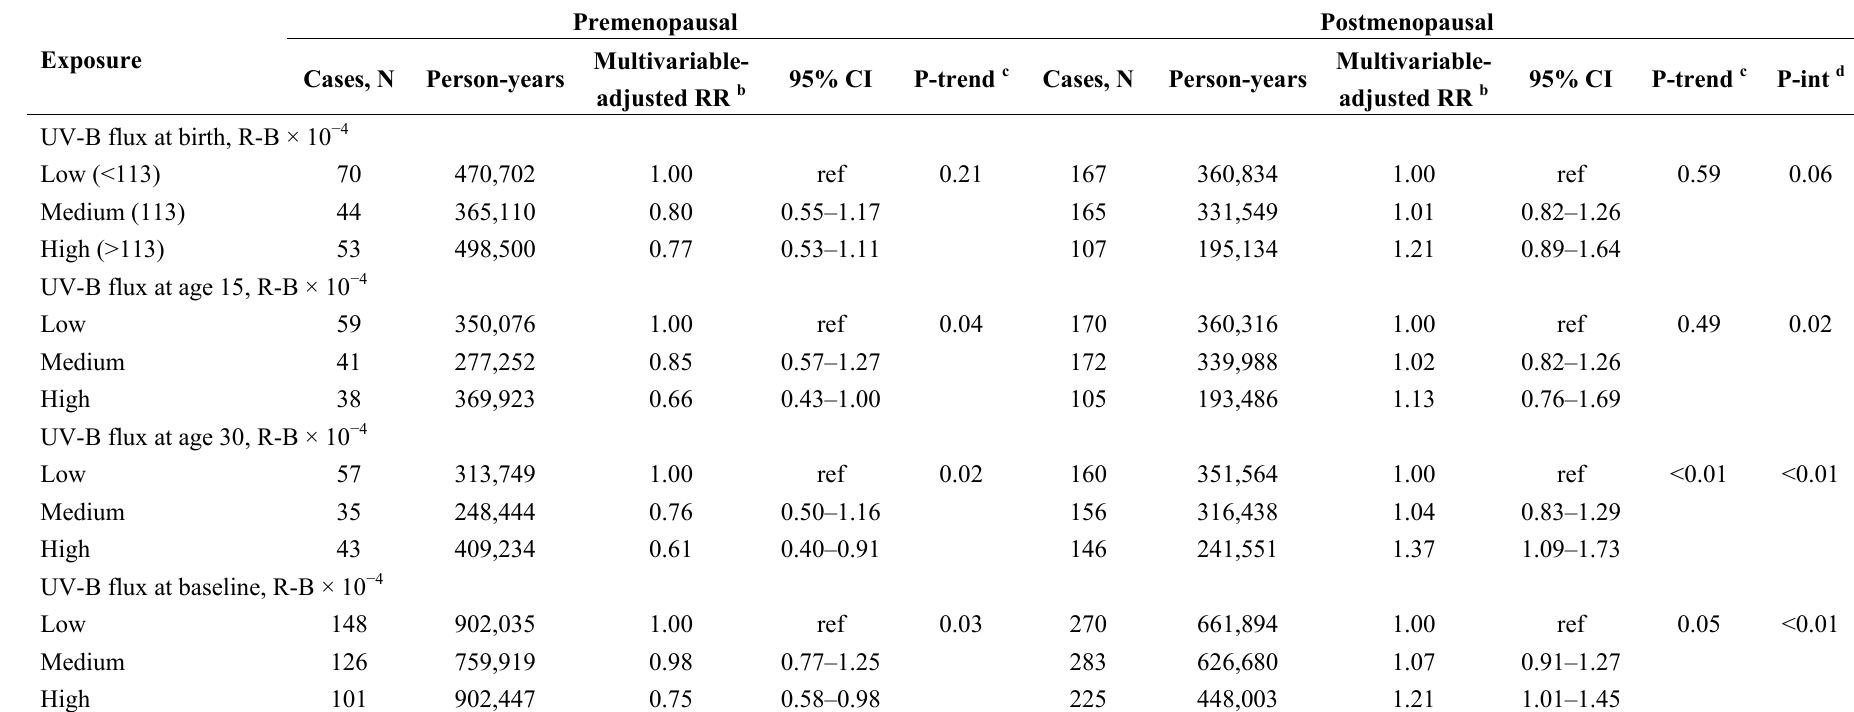
Table 3. Risk of ovarian cancer by menopausal status at diagnosis a